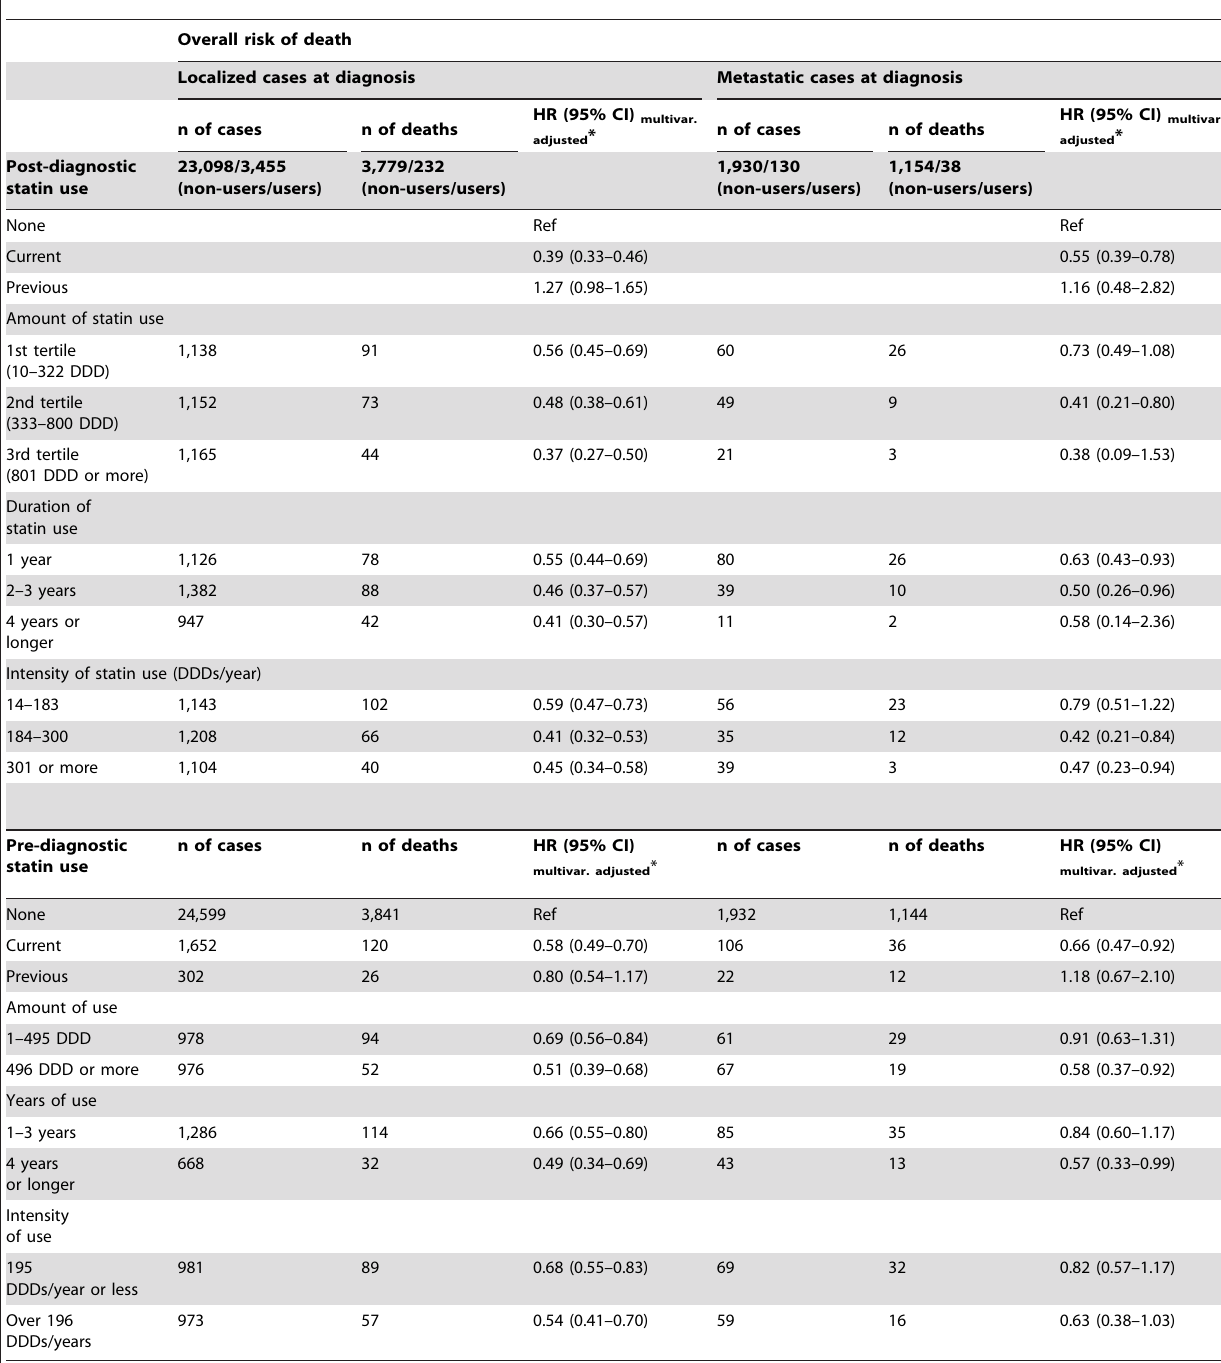
Table 5. Overall risk of death among post-diagnostic and pre-diagnostic statin users compared to